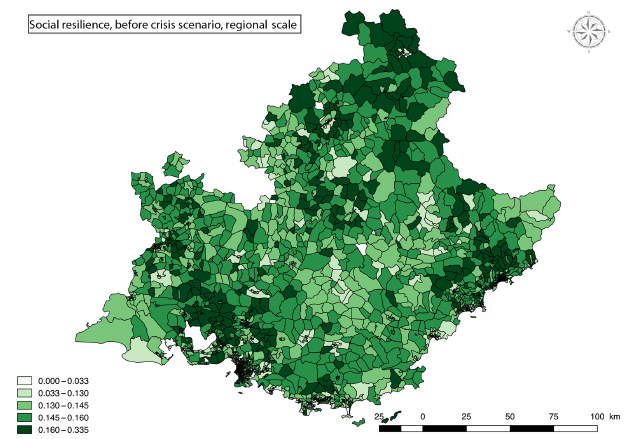
Figure 14. Social resilience, pre-crisis scenario, Provence-Alpes- Côte d’Azur regional scale – © Open Database License, “ODbL”